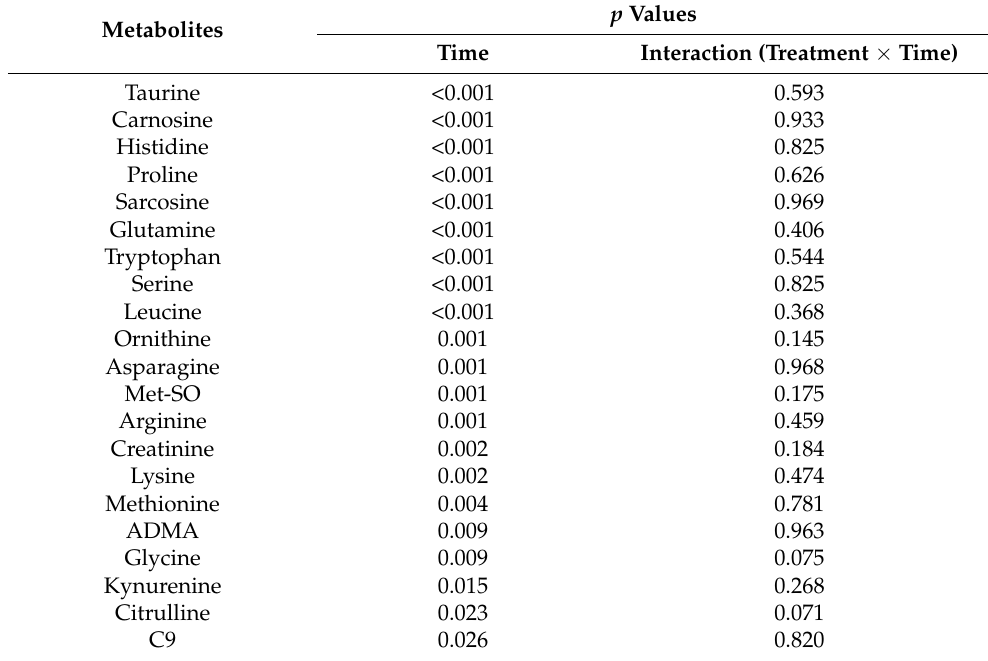
Table 4. Repeated measures analysis over time with the significant metabolites at least in one p